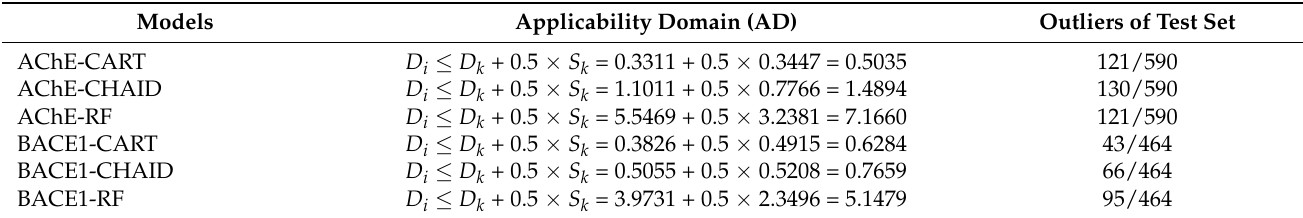
Table 2. Applicability domains of all six machine learning